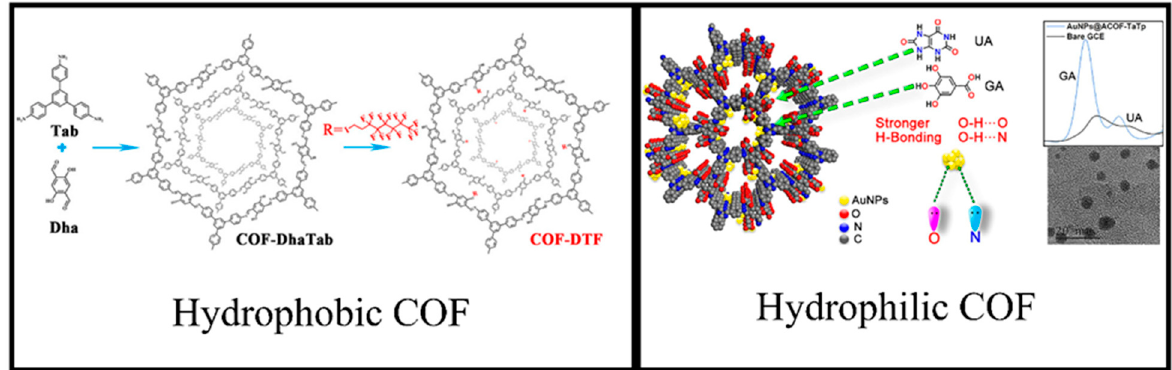
Figure 3. Examples of hydrophobic and hydrophilic COFs. Adapted with permission from references [100], copyright 2020 American Chemical Society and [101], copyright 2021 Elsevier.